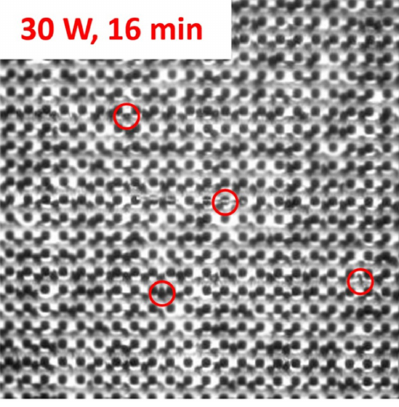
Figure A5. Representative image obtained after long-term plasma treatment (16 min, 30 W). Red circles indicate examples of irregular pattern formation.